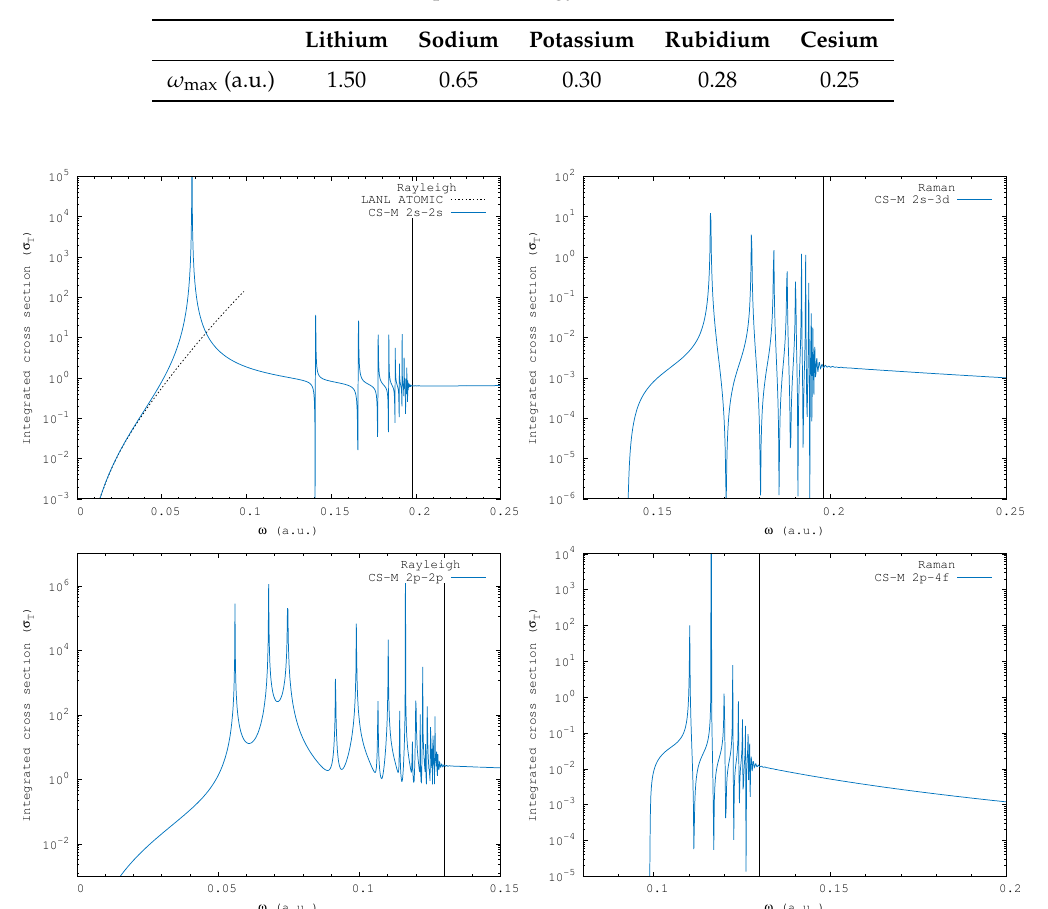
Table 2. Maximum incident photon energy considered for each alkali atom.